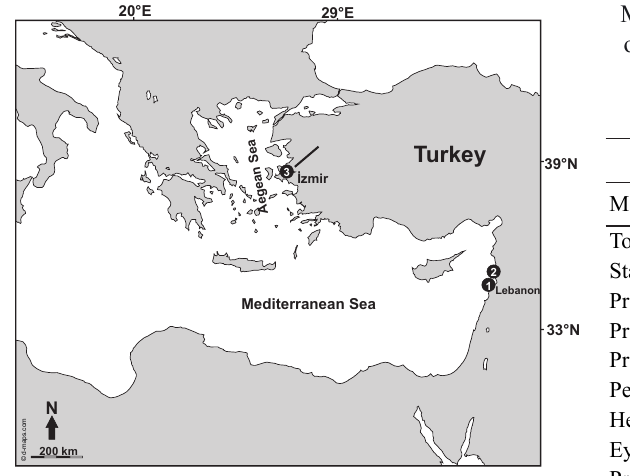
Fig. 2. Range extension of Lutjanus argentimaculatus in the coastal areas of the Mediterranean Sea (numbers and arrow indicate consecutive reports and the most recent record, respectively)